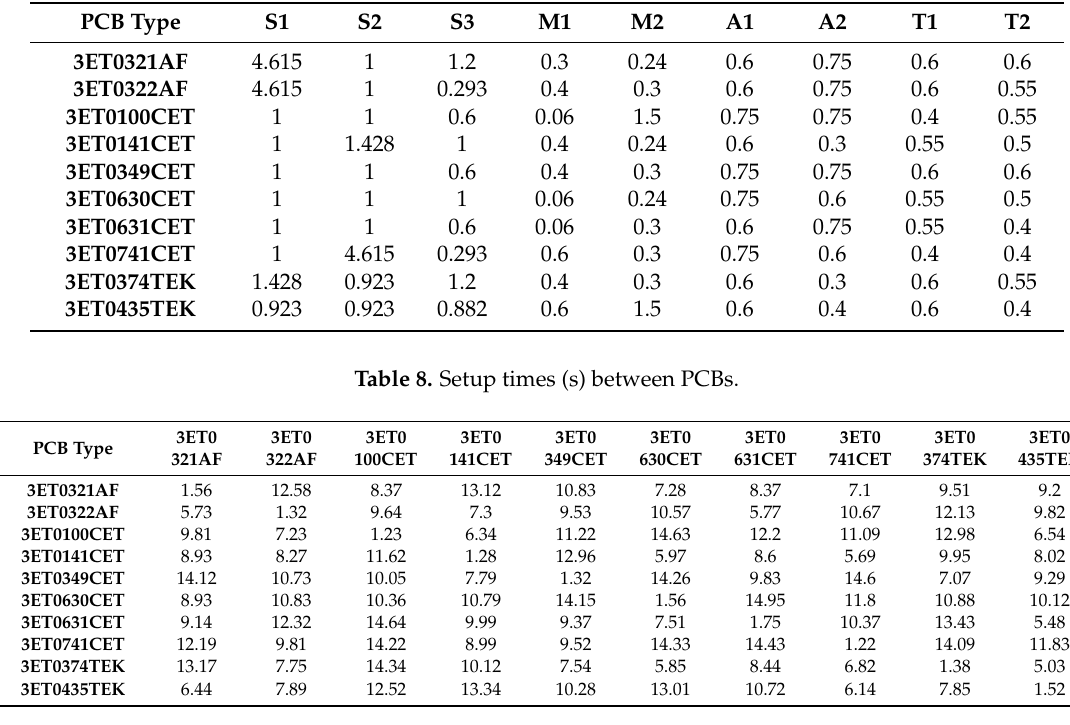
Table 7. Processing times (s) of different PCB (Printed Circuit Board) types in each production line.